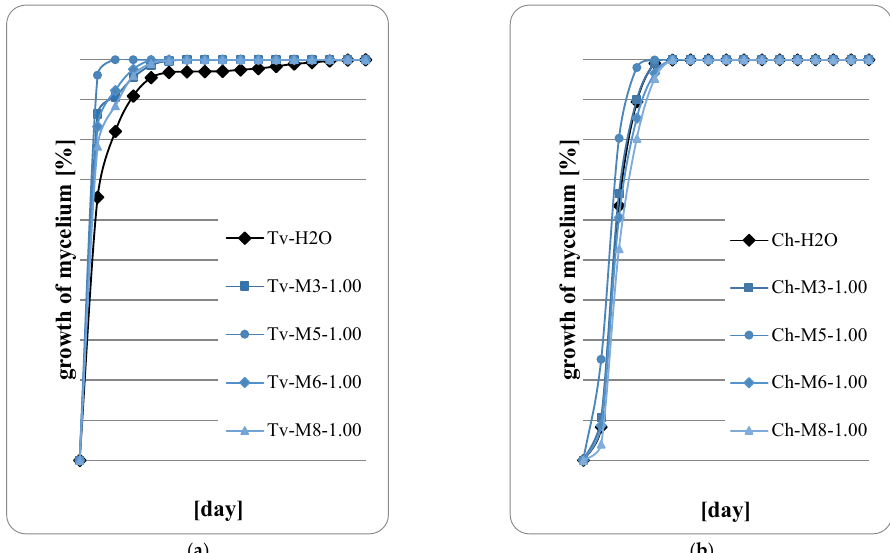
Figure 5. Fungal growth on wood: ( a ) T. viride; ( b ) Ch. globusom (explanation of symbols in the legend: Ch-H20—control, 1.00—sample code indicating the application of 400 g of extract per m 2 , M3— M. spicata ‘Morocco’, M5— M. spicata ‘Crispa’, M6— M. × piperita ‘Almira’, M8— M. suaveolens ’ Variegata’).